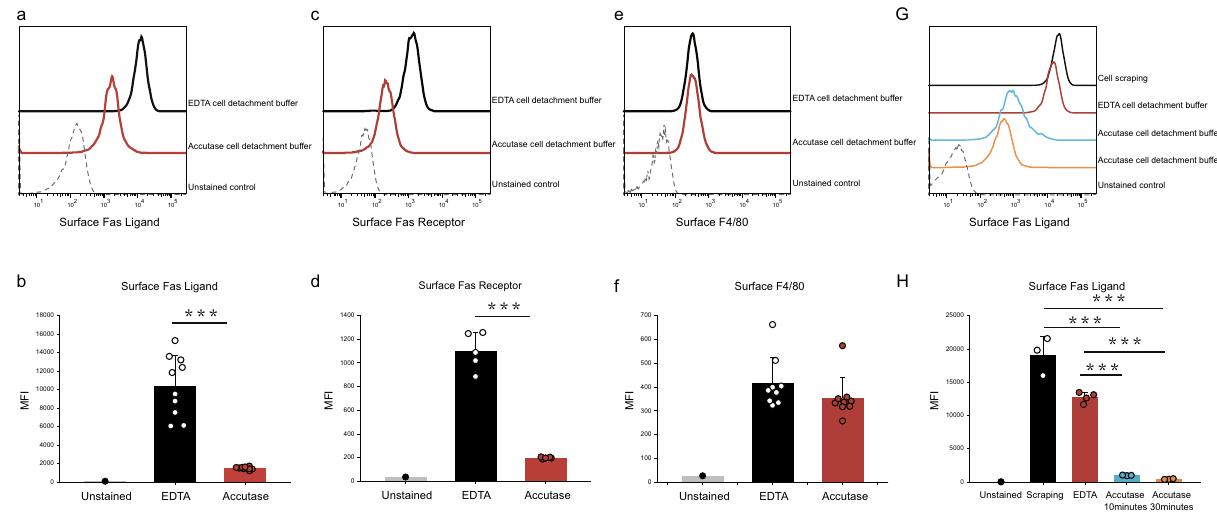
Figure 1. The effects of different cell detachment buffers on surface protein expression in RAW264.7 macrophages. ( a , c ) The surface expression of Fas ligand (FasL) and Fas receptor was detected by flow cytometry in RAW264.7 murine macrophages treated with either EDTA or accutase for 10 min. ( b , d ) Statistical analysis revealed a significant difference in surface FasL expression between the EDTA and accutase treatment groups. ( e , f ) Neither EDTA nor accutase buffer incubation affected surface F4/80 proteins in RAW264.7 cells (p = 0.2). ( G,H ) The EDTA cell detachment buffer had minor effects on cell surface FasL expression when applied for 30 min compared to those of the cell scraping method. Cells incubated with the accutase cell detachment buffer for either 10 or 30 min exhibited significantly decreased surface FasL expression. (***p < 0.001, one-way ANOVA). MFI mean fluorescence